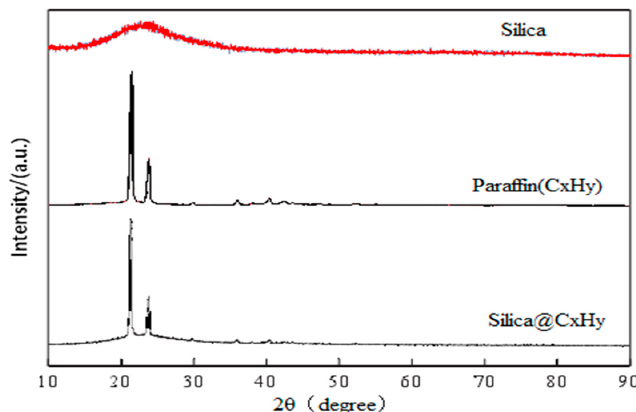
Figure 13. Comparison of Diffraction Spectra of Silica Nanoparticles, Paraffin, Silica@Paraffin.